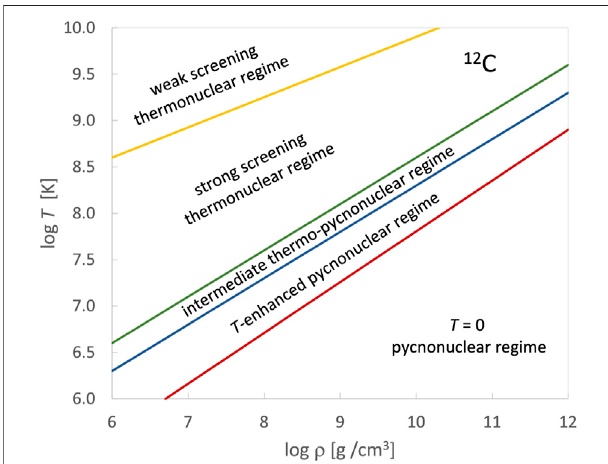
FIGURE 1 | Temperature-density diagram covering the various screening regimes for 12 C matter. The diagram follows the de fi nition by Salpeter [4] and subsequent work by Gasques et al. [5] (for the de fi nition and treatment of screening in the intermediate thermo-pycnonuclear and T - enhanced pycnonuclear regimes the reader is referred to